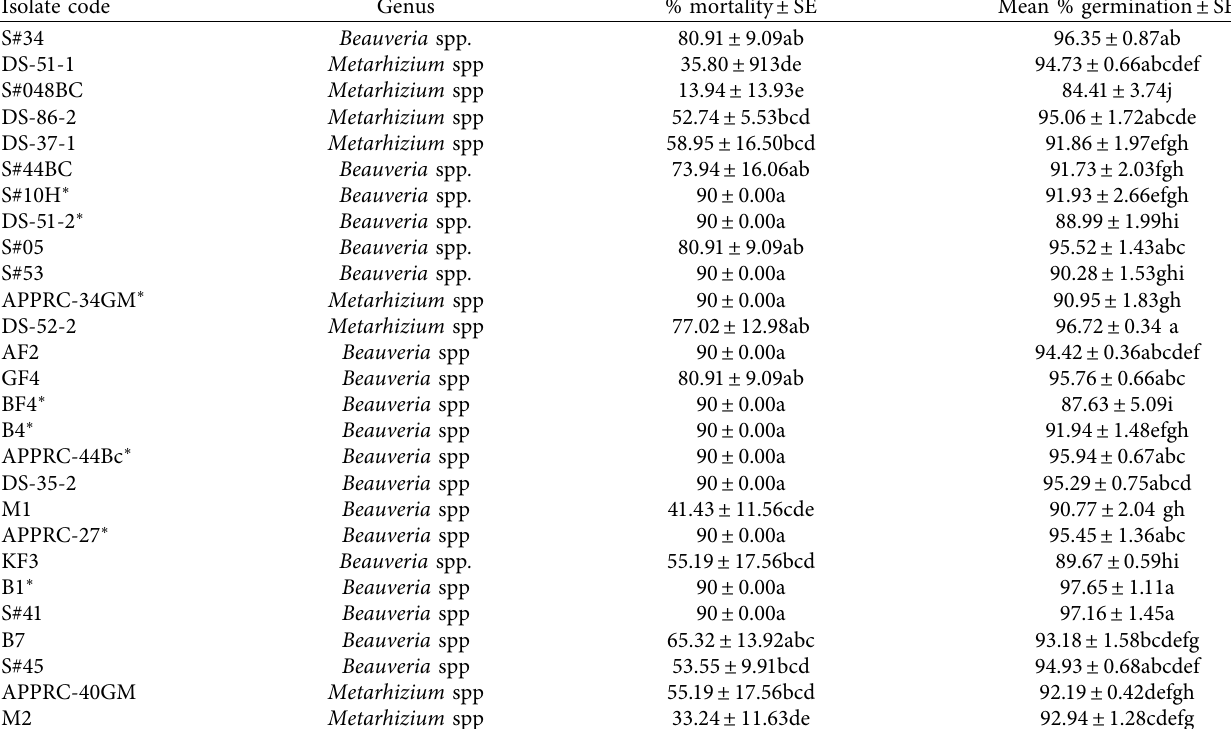
Table 2: Conidia viability and pathogenicity of entomopathogenic fungi (EPF) isolates against larvae of G. mellonella. Isolate code